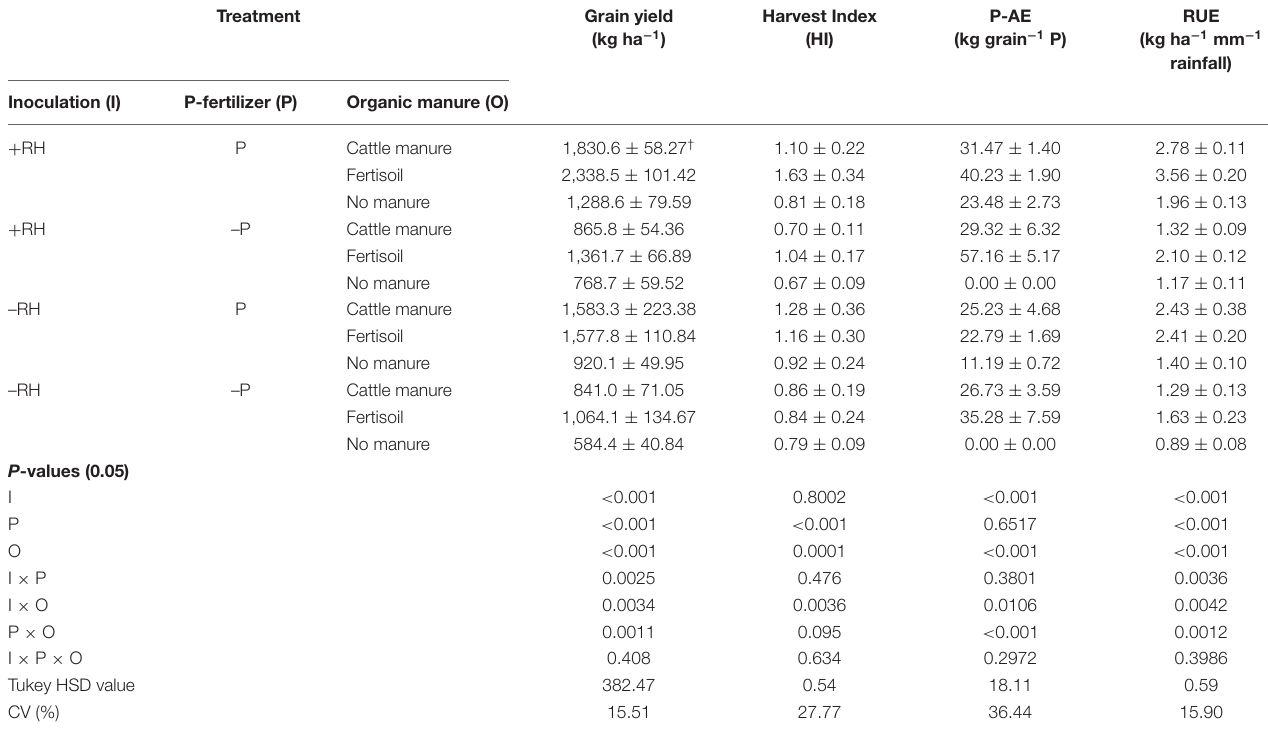
TABLE 1 | Soybean grain yield, Harvest Index, Agronomic, and Rain water use efficiencies as affected by the application of rhizobia, P-fertilizer, and organic manure.